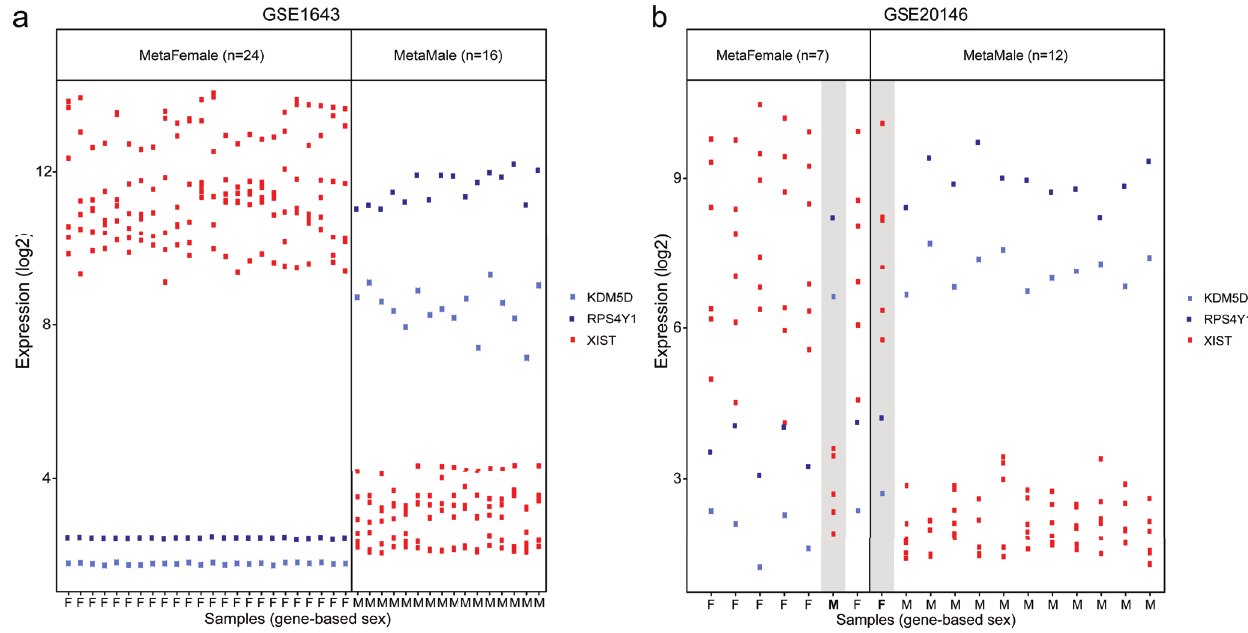
Figure 1. Representative plots showing expression levels of sex-specific probesets. Expression level of probesets representing the XIST (red), KDM5D (black) and RPS4Y1 (blue) genes. “MetaFemale” and “MetaMale” indicate the meta-data annotated sex of the samples and their total number in brackets. The “M” and “F” along the X axis indicates the gene-based sex of the samples, as determined by k-means clustering. Log -transformed expression levels are plotted. ( a ) Representative dataset with no mismatched samples. ( b ) Representative 2 dataset with two mismatched samples (highlighted with grey bars). Gene-based sex that contradicts the annotated sex of the sample is highlighted in bold at